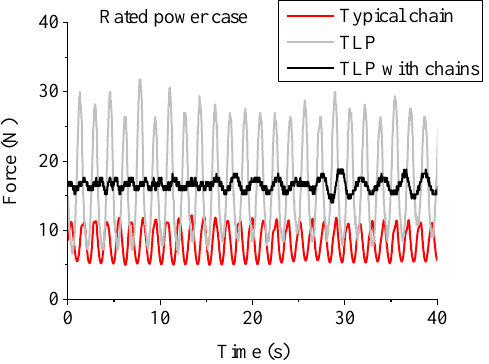
Figure 7. The force comparison of the two FOWT’s mooring systems under rated power